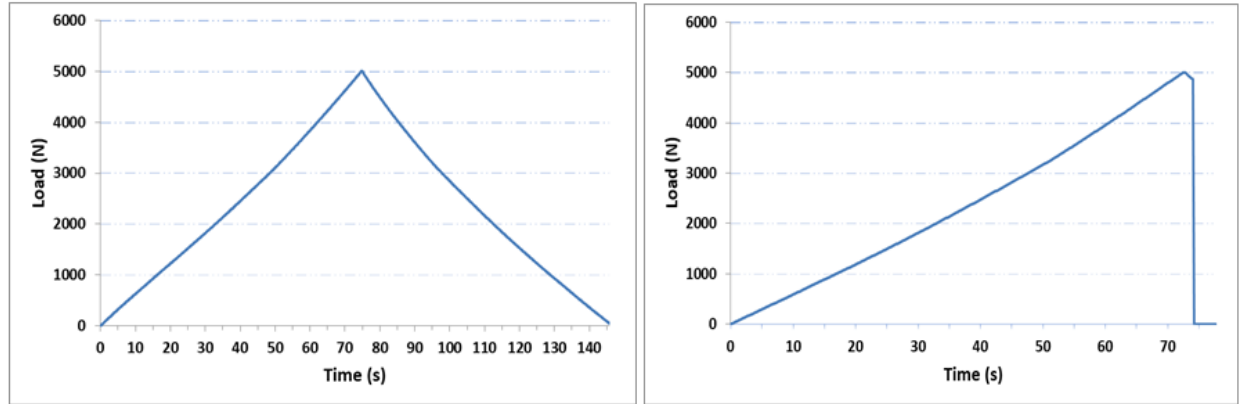
Figure 7. Load profiles generated by the Instron 3367 30 kN Universal Strength Tensile Testing. Left : gradual changes; Right : sudden changes.